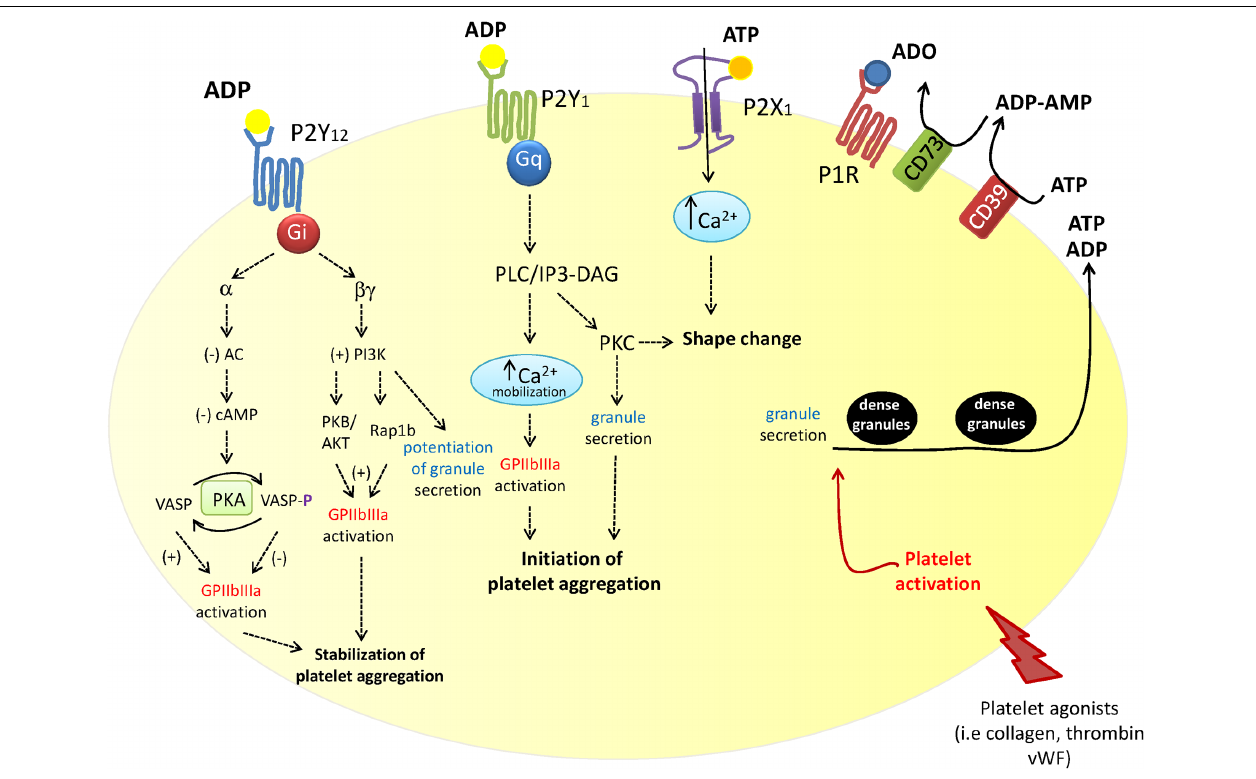
FIGURE 1 | Schematic overview of the contribution of the three P2 purinergic receptor subtypes, P2Y 1 , P2Y 12 , and P2X 1 in platelet activation. P2Y 12 receptor plays a central role in ADP-mediated platelet activation. Platelet exposure to primary platelet agonists including thrombin, collagen and Von Willebrand factor (vWF) results in their adhesion followed by the release of ATP and ADP from dense granules. Extracellular ATP is rapidly metabolized into ADP, AMP and finally to adenosine by the ecto-enzymes CD39 and CD73. Secreted ATP and ADP, as well as ADP deriving from ATP degradation, activate P2Y 1 , P2Y 12 , and P2X 1 receptors (as depicted). P2Y 12 receptor stimulation modulates the growth and stability of thrombus by potentiating platelet dense granule release, platelet aggregation and procoagulant activity (Kunapuli et al.,